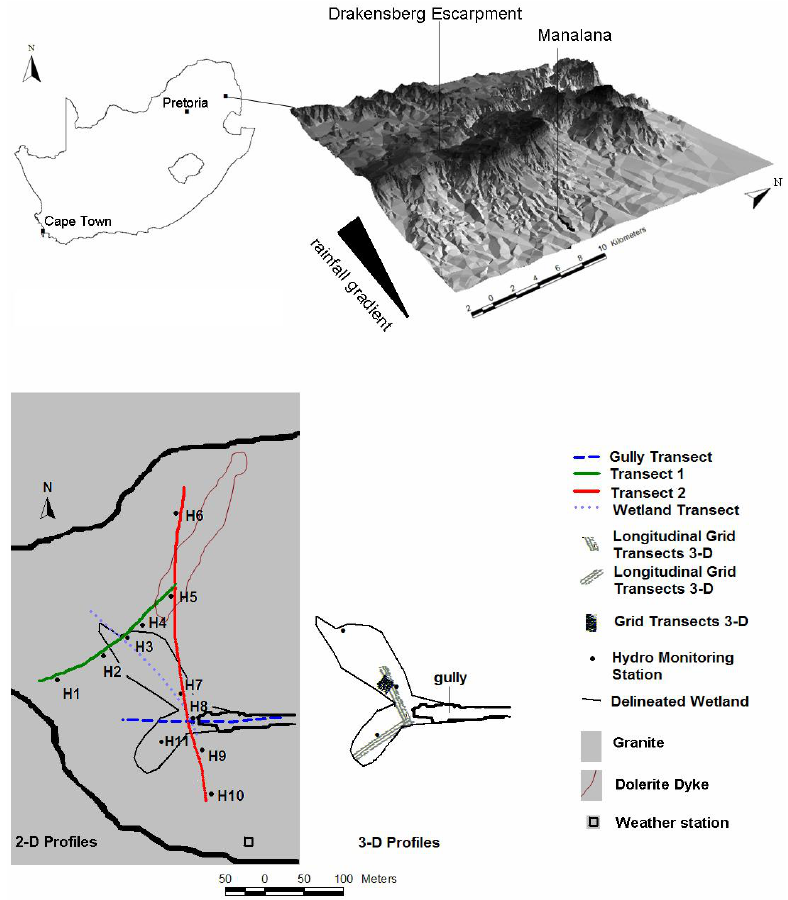
Fig. 1. Map and location of the Manalana sub-catchment within South Africa (above) with delineated wetland with the location of ERI transects and gully head (labels refer to hydrological monitoring